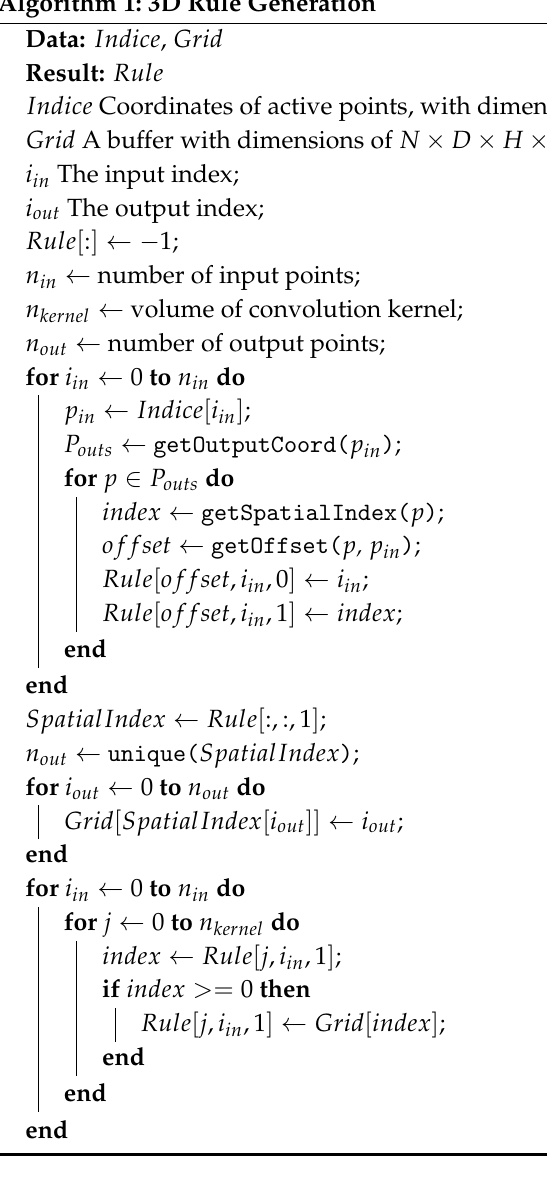
Algorithm 1: 3D Rule